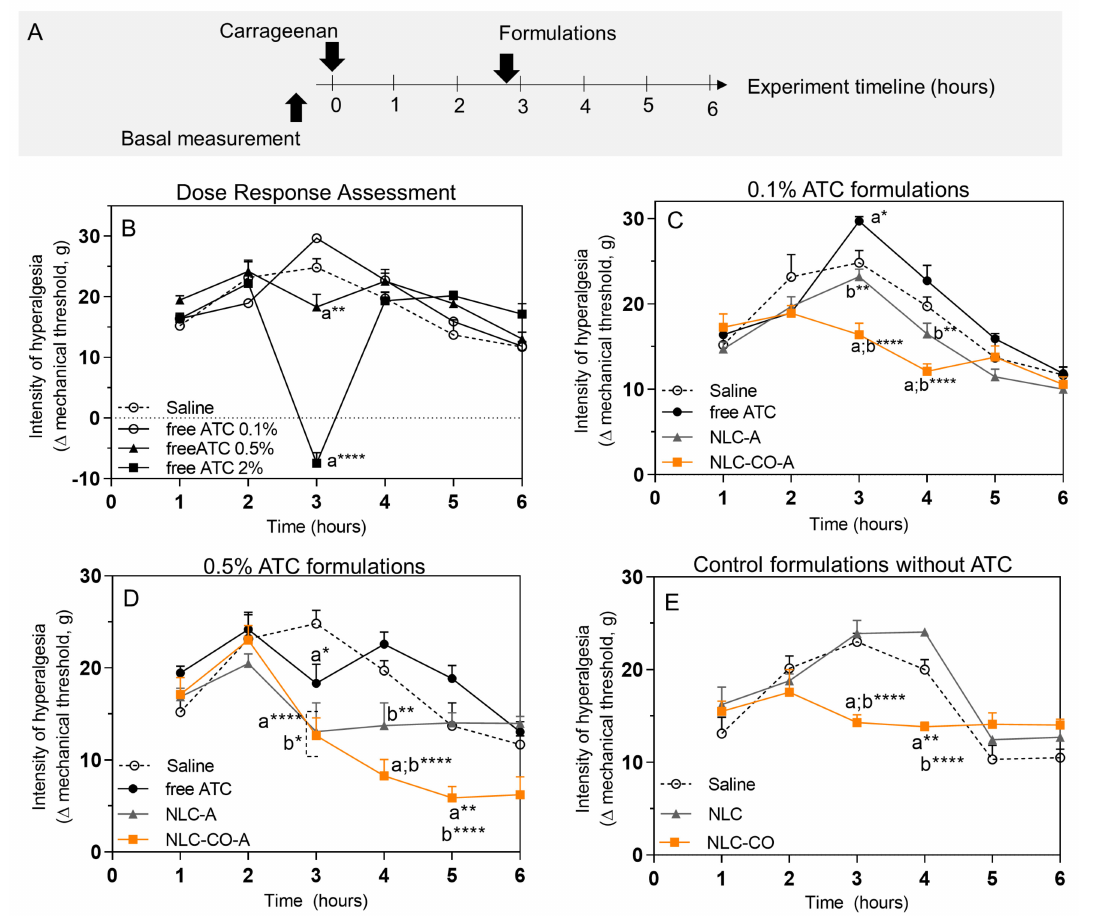
Figure 3. Behavior measurements of inflammatory hyperalgesia induced by λ -carrageenan in vrats. ( A ) Experimental design timeline; ( B ) mechanical nociceptive threshold measured by electronic von Frey test after treatment with saline solution (control) and free articaine solution at 0.1%, 0.5%, and 2%. ( C ) Nociceptive threshold of articaine in solution (free ATC) or encapsulated in NLC (NLC-A, NLC-CO-A) at 0.1% or ( D ) at 0.5%. ( E ) Nociceptive threshold of control NLC without